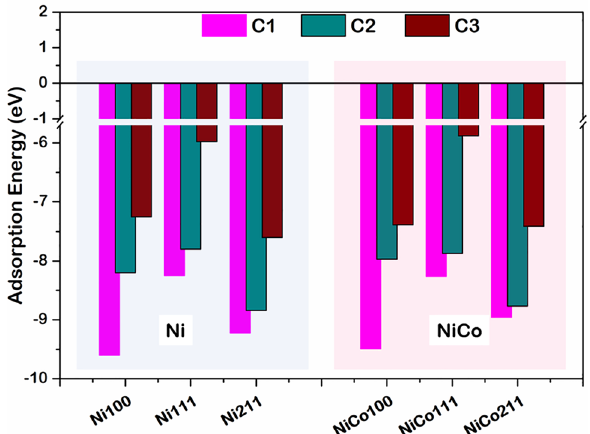
Figure 4. Adsorption energies (E ads ) of C1, C2, and C3 coke species on Ni and NiCo